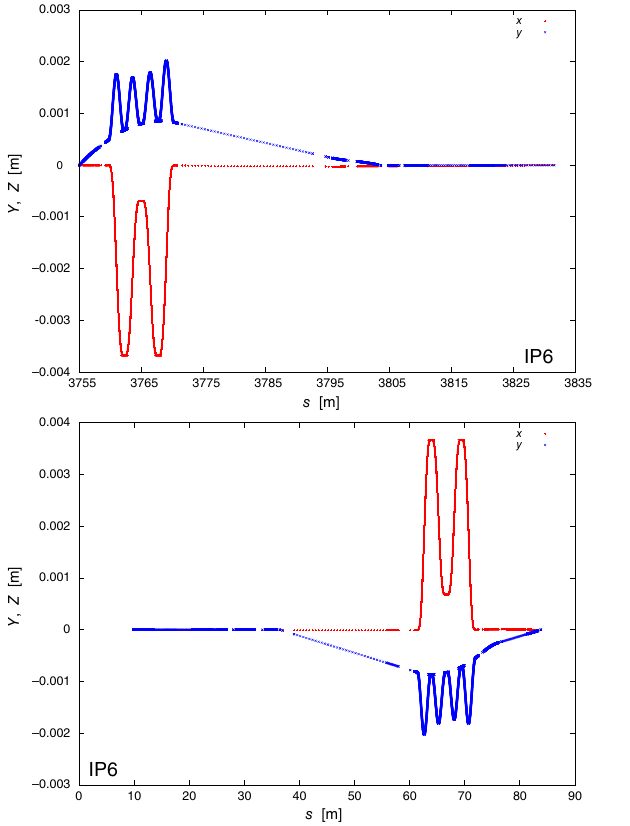
FIG. 28. Local horizontal (red) and vertical (blue) closed orbit bumps in the IP6 (STAR) rotators in the present simulations, using OPERA field maps. IP6 (STAR) is at s ¼ 0 , increasing s is CCW. Top: L þ R þ L þ R þ rotator, upstream of IP6, moves spin ⃗ n 0 from vertical in the arc to longitudinal at IP6. Bottom: L − R − L − R − rotator downstream of IP6, moves spin ⃗ n 0 from longitudinal at IP6 to vertical in the arc.